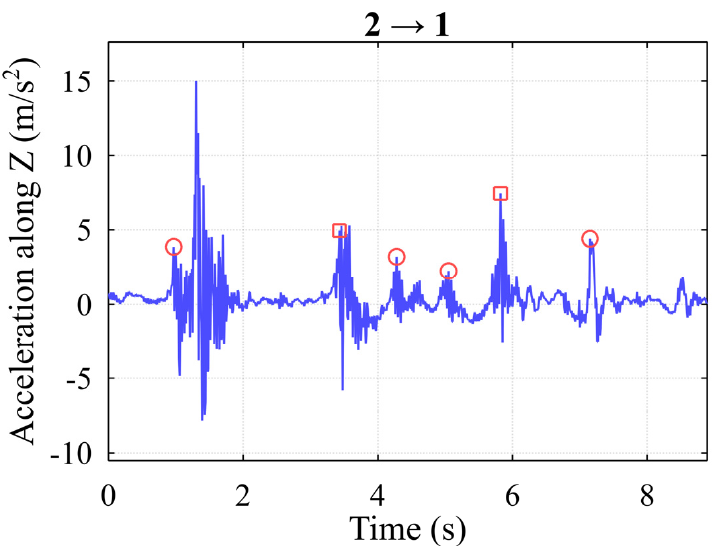
Figure 25. Primary and secondary impacts along the Z-axis (here the red circles indicate the initial impacts and the red squares indicate the secondary impacts).